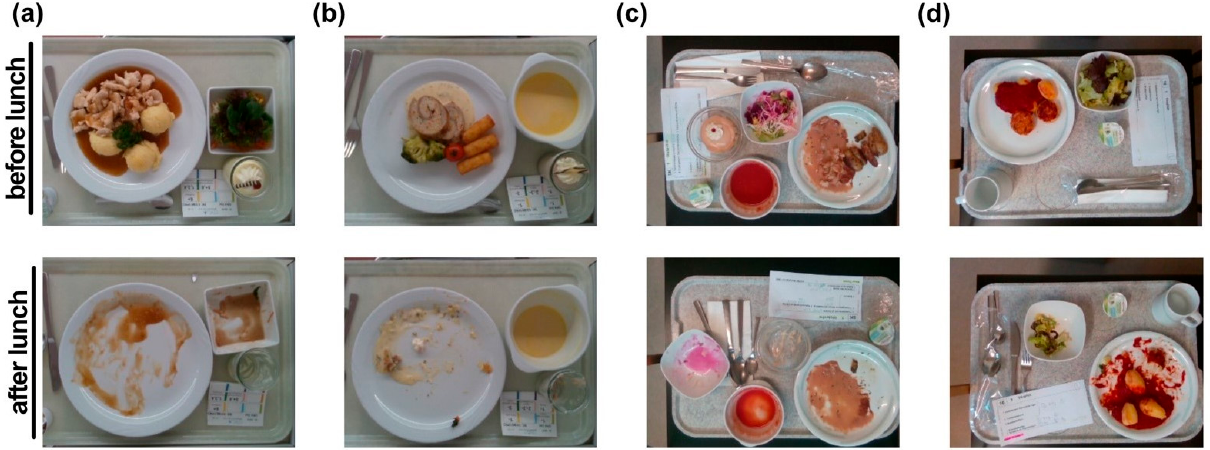
Figure 2. Sample images before and after meal consumption from Geriatrische Klinik St. Gallen ( a , b ) and from the Bern University Hospital [24] ( c , d ).